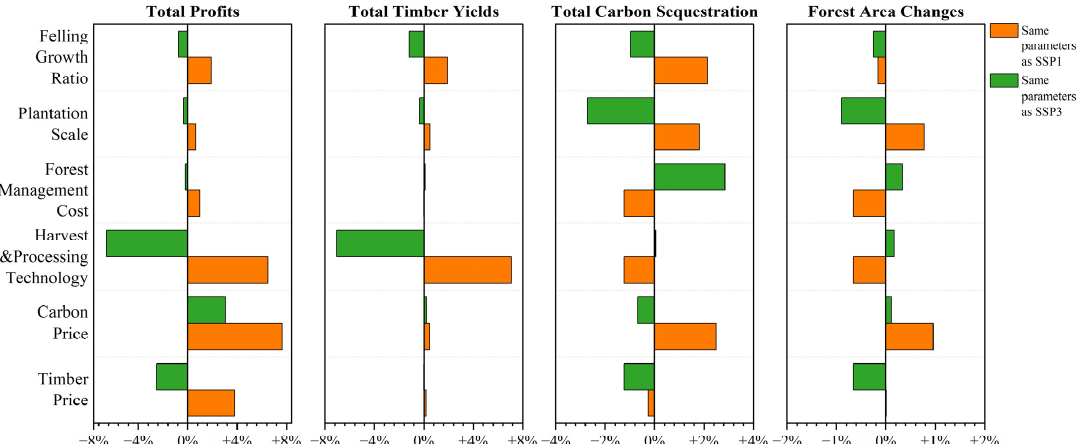
Figure 6. Key model estimates for other socioeconomic parameter sensitivity in all SSPs. The bars in green and orange colors represent the changes in percentage between sensitivity analysis result and the SSP2 result.